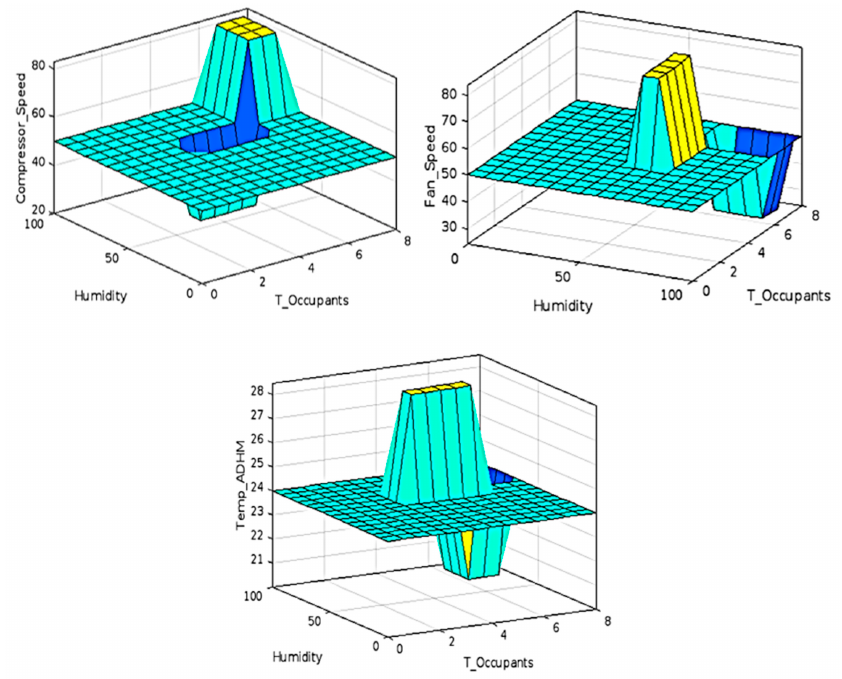
Figure 3. Surface viewer of compressor speed, fan speed, and temperature in relation to T-occupants (truth) and humidity.